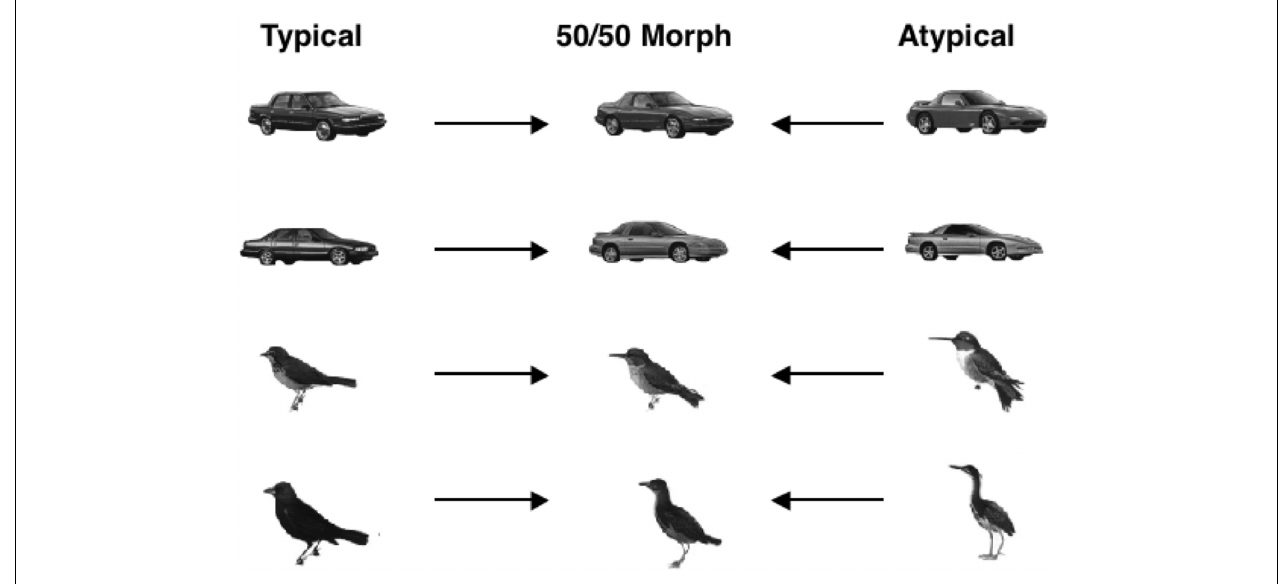
FIGURE 5 | Examples of birds and car exemplars rated high or low in typicality and their 50/50 morphs used inTanaka and Corneille (2007) study.